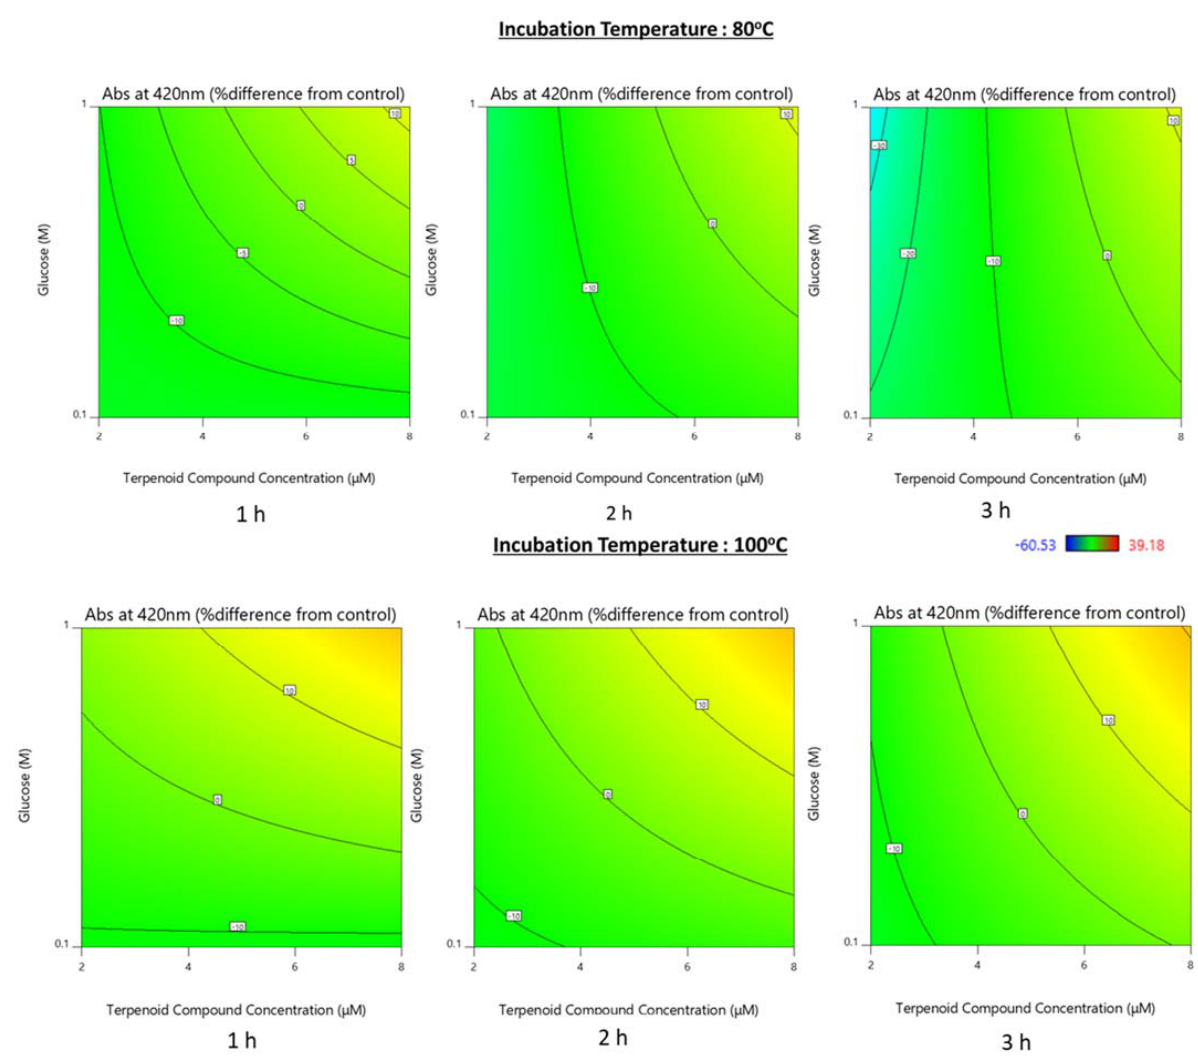
Figure 7. The effect of terpenoid compound concentration and glucose concentration on advanced glycation products formation (420 nm) expressed as percentage difference from control (no terpe ‐ noid compound added) at pH 7.2 and 80 °C and 100 °C. Figures indicate average values of all three terpenoid compounds (linalool, aniseed oil and thymol).